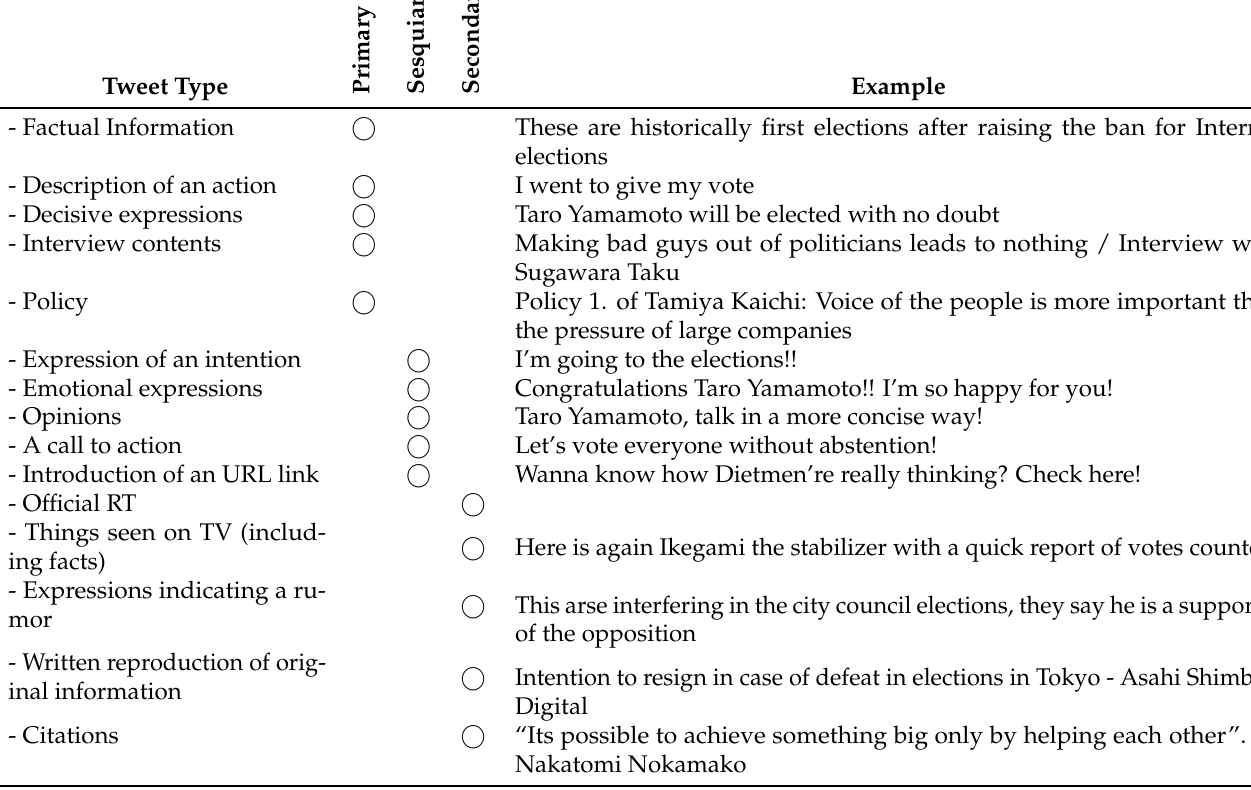
Table 4. Redefinition of classification